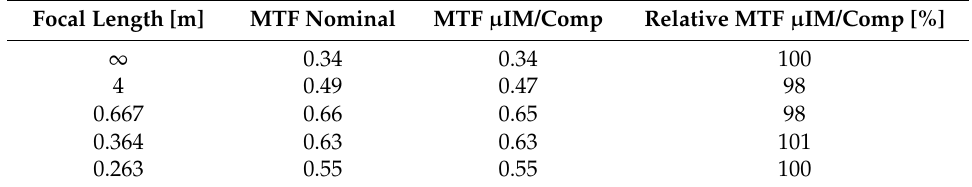
Table 4. MTF of the manufactured optics compared with the nominal design (central field, evaluated at 40 cyc/mm).